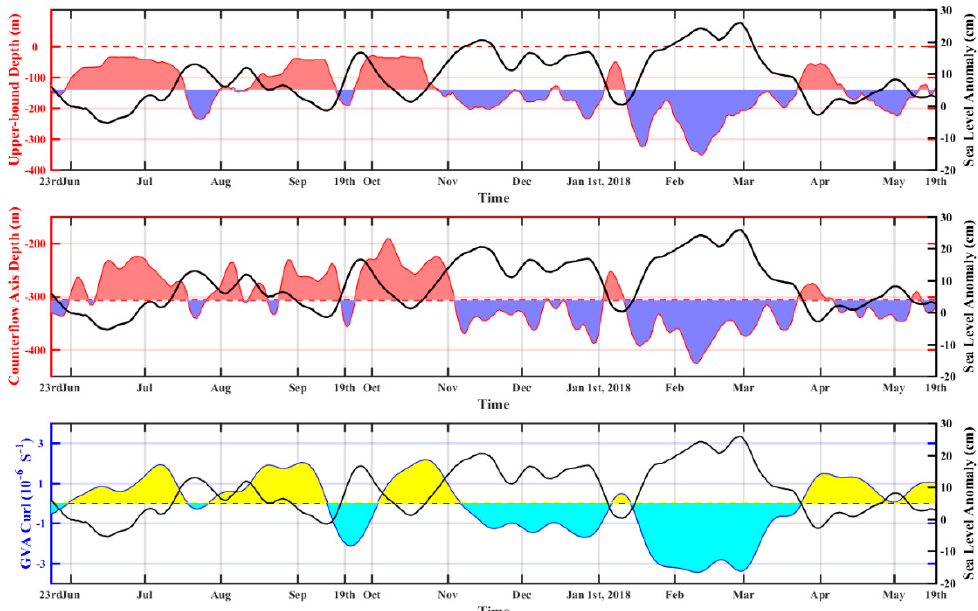
Figure 4. The daily sea level anomaly (SLA) (black lines), GVA curl (blue lines), and depths of the upper boundary and axis of the counter-flow (red lines). A 9-d low-pass filter was applied to the primary data. The SLA and GVA curl at the in situ site were derived from satellite altimeter data, and the depths of the upper boundary and axis of the counter-flow were derived from in situ observations. The SLA was defined as a deviation from mean sea level for the analysis period, and the seasonal variation was removed.